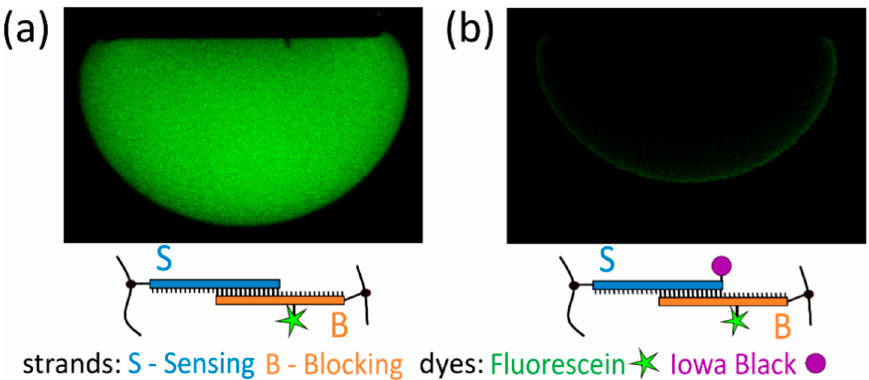
Figure 4. ( a ) A DNA-co-acrylamide (Aam) hydrogel with 10% of the B strands labelled with Fluorescein dT imaged in buffer using CLSM. Fluorescein dT was attached between the 12th and 13th base from 5 ′ end. Laser power during imaging was 3.5% ( b ) A DNA-co-Aam hydrogel with 10% labelled B strands and 100% S strands carrying a dark quencher Iowa Black at their 3 ′ ends. Imaged with a laser power of 10%.